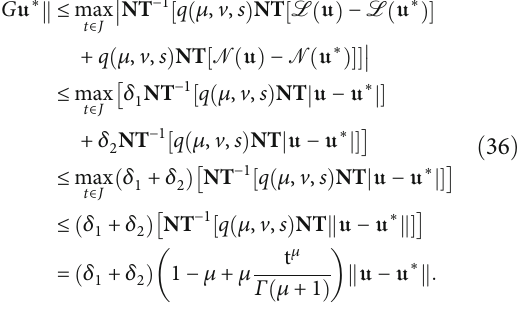
with existing methods of Example 2 when λ = 0 : 001 . ABC NTDM ABC